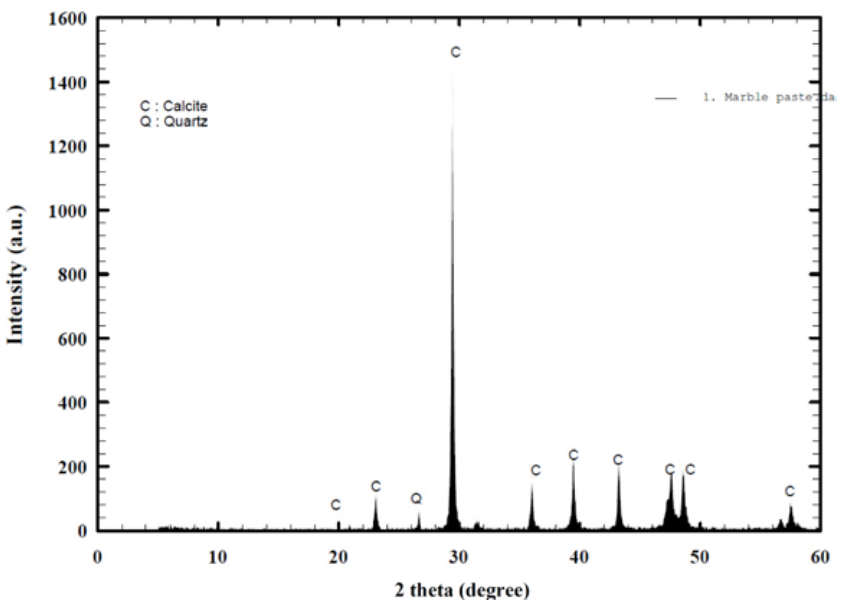
Figure 3. XRD results for marble sludge.